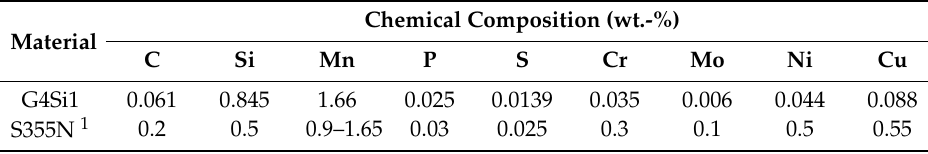
Table 1. Chemical composition of the used materials.